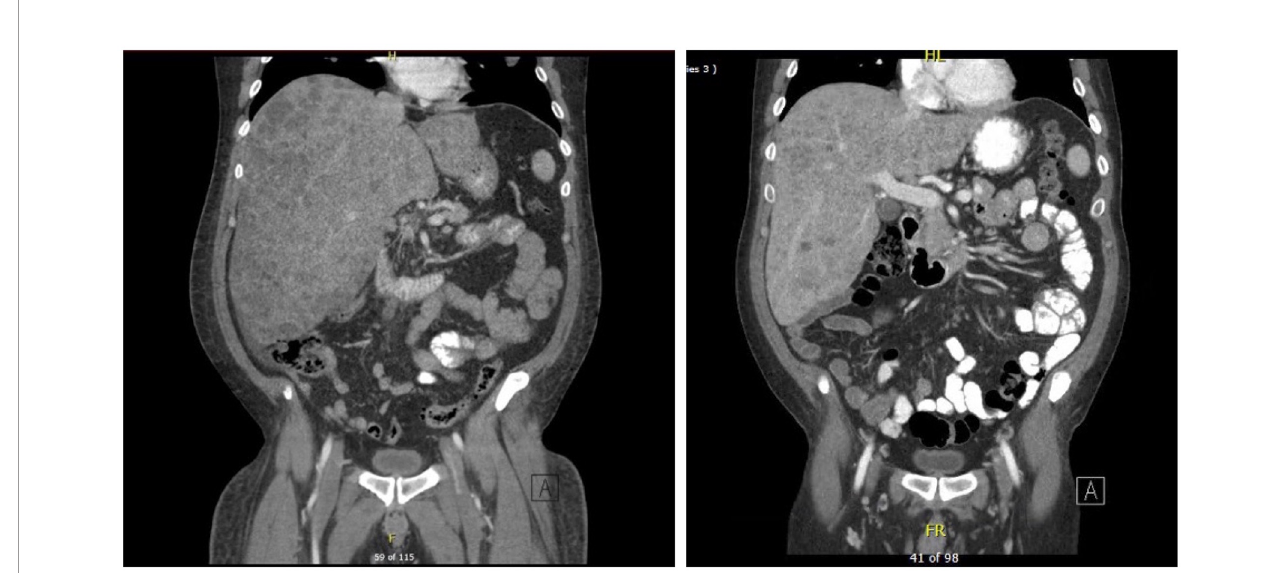
FIGURE 2 | CT scan of abdomen showing innumerable lesions throughout the liver consistent with metastatic disease on day 1 on the left vs day 104 on the right with improved lesion